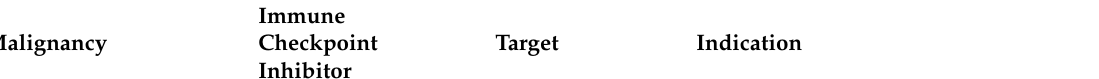
Table 1. The immune checkpoint inhibitors approved by the European Medicines Agency (EMA) in lung